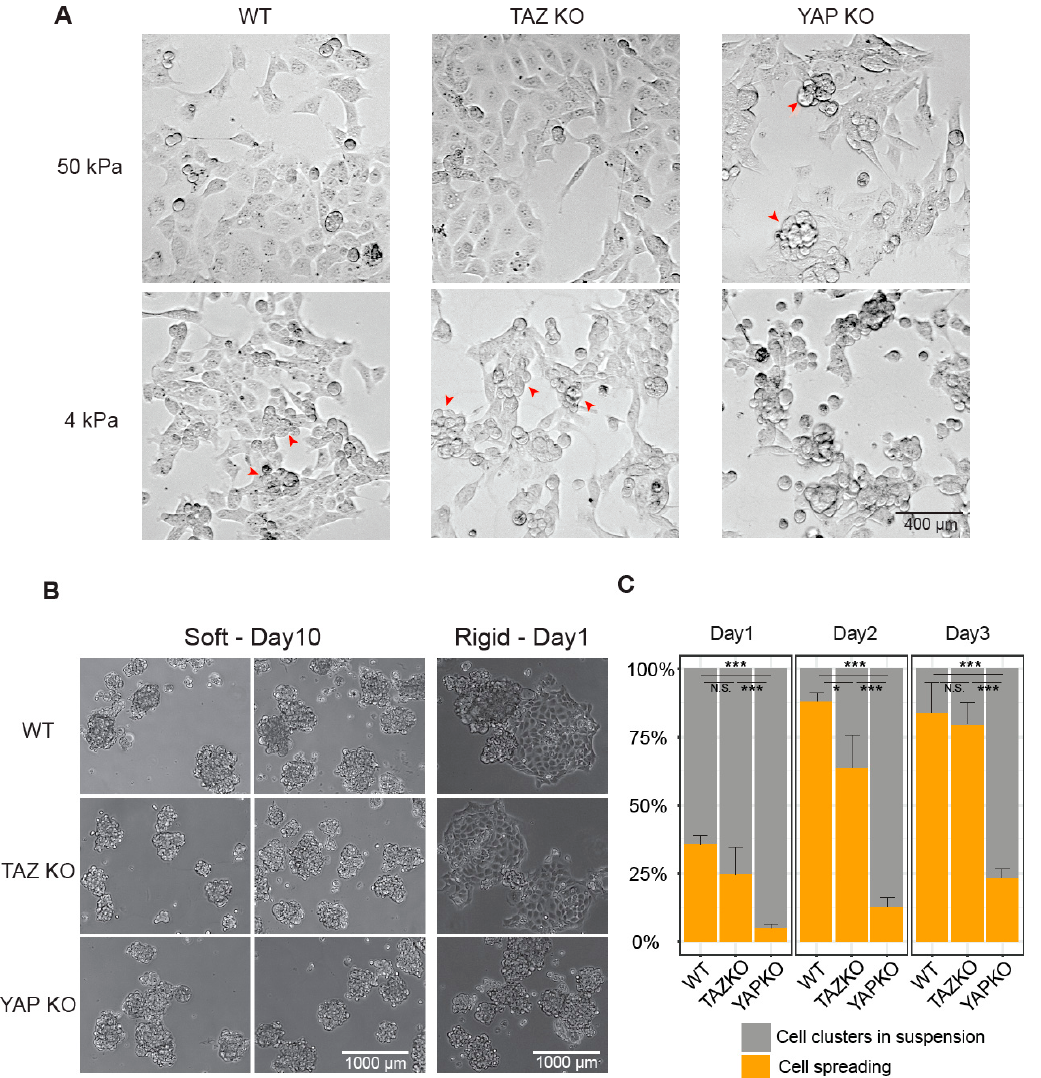
Figure 4. Wildtype (WT), TAZ knockout (KO), and YAP KO in different rigidity and in response to altering rigidity. ( A ) Representative images of WT, TAZ KO, and YAP KO cells cultured in polyacrylamide (PAA) hydrogel dishes with soft (4 kPa) and stiff (50 kPa) rigidity. ( B ) Representative images of WT, TAZ KO, and YAP KO cells maintained in 0.5 kPa PAA hydrogel dish for 10 days; and 1 day after transferring the cells to the rigid plastic dish. ( C ) Quantification of cells either attached (ochre) or in suspension (grey) on days 1, 2, and 3 after transferring cells to the rigid conditions. Quantification was done by visual inspection of 6–10 fields of view of phase-contrast microscopy per sample. Error bars indicate standard error of the mean, calculated from three biological replicates. The statistical significance level via two-tailed unpaired Student’s t -test was summarized with asterisks: p < 0.001 (***), p < 0.05 (*), and p > 0.05 (not significant,